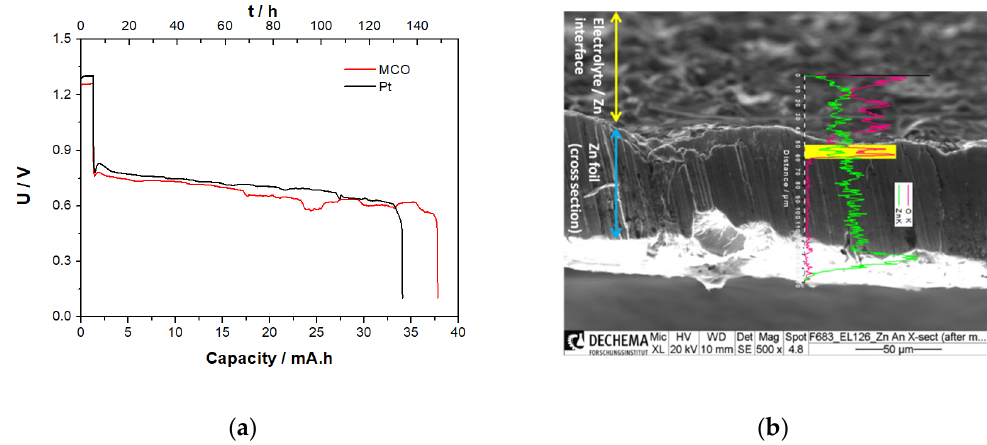
Figure 15. ( a ) Discharge profile of zinc/air cell with MCO and Pt as GDE at 100 µA cm − 2 and ( b ) SEM image of a cross-sectional Zn electrode after compete discharge of ChAcO + 0.01 M ZnAcO 2 + 30% H 2 O cell containing MCO GDE at 100 µA cm − 2 in ambient air with an EDX signal of specific elemental count rate profile in line scan for oxygen (red) and zinc (green) along and zinc surface in contact with an electrolyte, zinc foil cross section, and zinc foil in contact with the current collector (bright area). An enlarged SEM and line scan image are provided in Figure S6 for better readability.